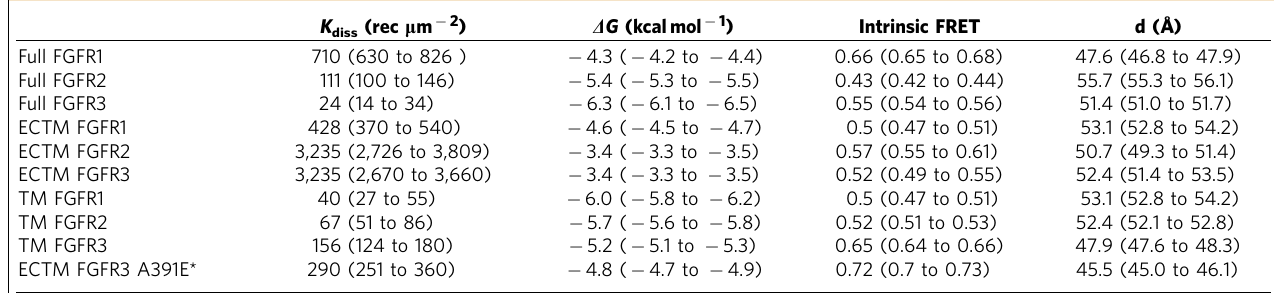
The parameters were obtained from least-square fits of a dimer model to the FRETdata. K diss : two-dimensional dissociation constants , D G: dimerization free energies (dimer stabilities) calculated using equation(10), d :effectivedistancebetweenfluorescentproteinsinadimer,calculatedfromtheintrinsicFRETefficienciesusingequation(12).Bestfitsareshown,alongwiththe67%confidenceintervals (standard errors). The values shown in parenthesis are the lower and upper bounds for the confidence intervals, determined from the fit. *Data from ref.